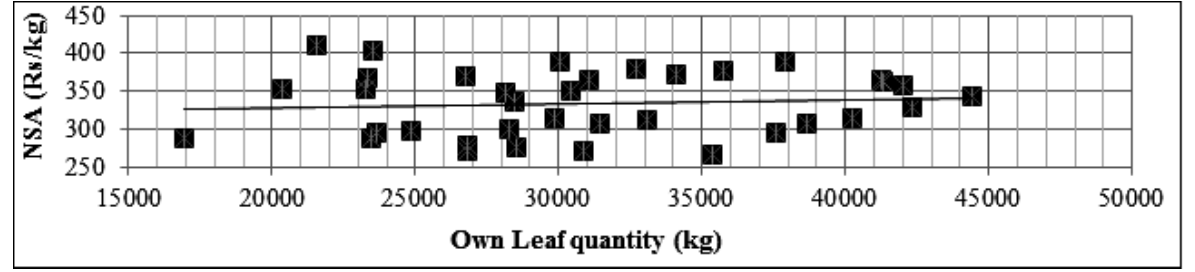
Fig 12: Relationship of Main Grade Percentage with NSA in Western When considering the source of the green leaves for produce made tea, the own leaf has given positive relationship with NSA than in Nuwara Eliya. But same conditions appeared in variations of NSA for equal own leaf values (see fig 13).